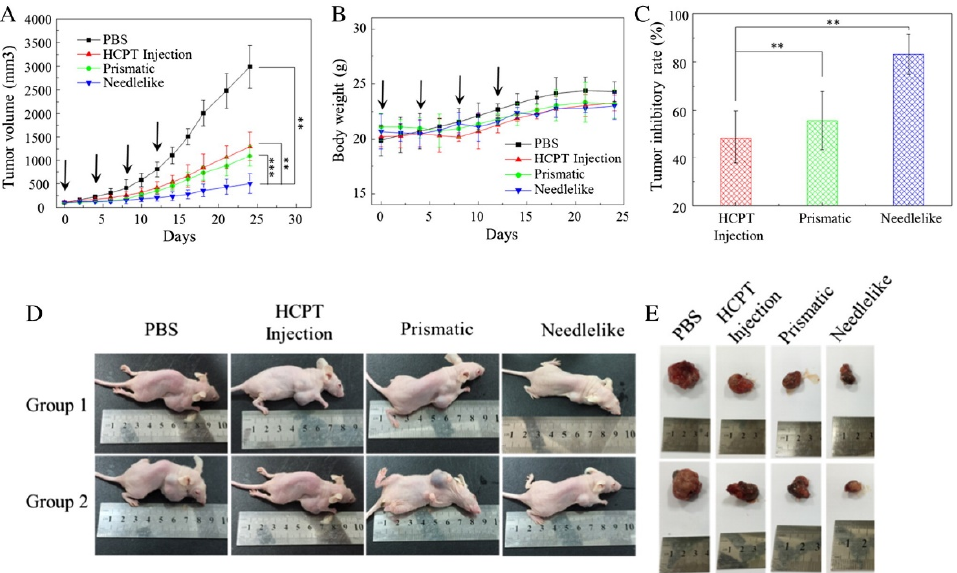
Figure 2. In vivo anticancer activity studies of 10-hydroxycamptothecin polymorphic nanoparticle dispersions. ( A ) Effects of tumor volume after intravenous injection of different dispersions. ( B ) Variation of the relative body weight of the mice after intravenous administrations. ( C ) The tumor inhibitory rate (TIR) after different treatments in A549 tumor-bearing nude mice. Data are represented as mean ± SD (n = 10). Statistical significance: ** p < 0.01; *** p < 0.005. ( D ) Representative tumor-bearing mice are treated with different formulations for 24 days. ( E ) Representative tumors collected at the end of the experiment. Reprinted with permission from [63]. Copyright © 2022 Elsevier.